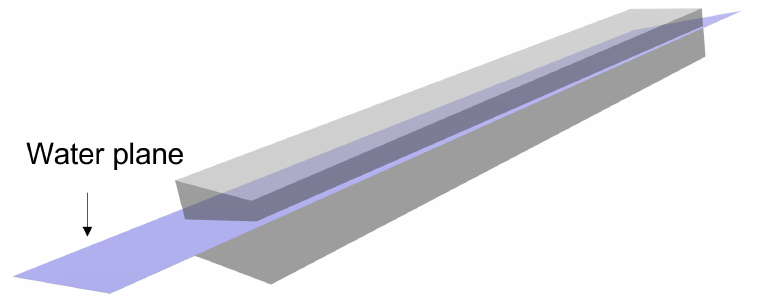
Figure 3. Intersection of inclined water plane and ship.